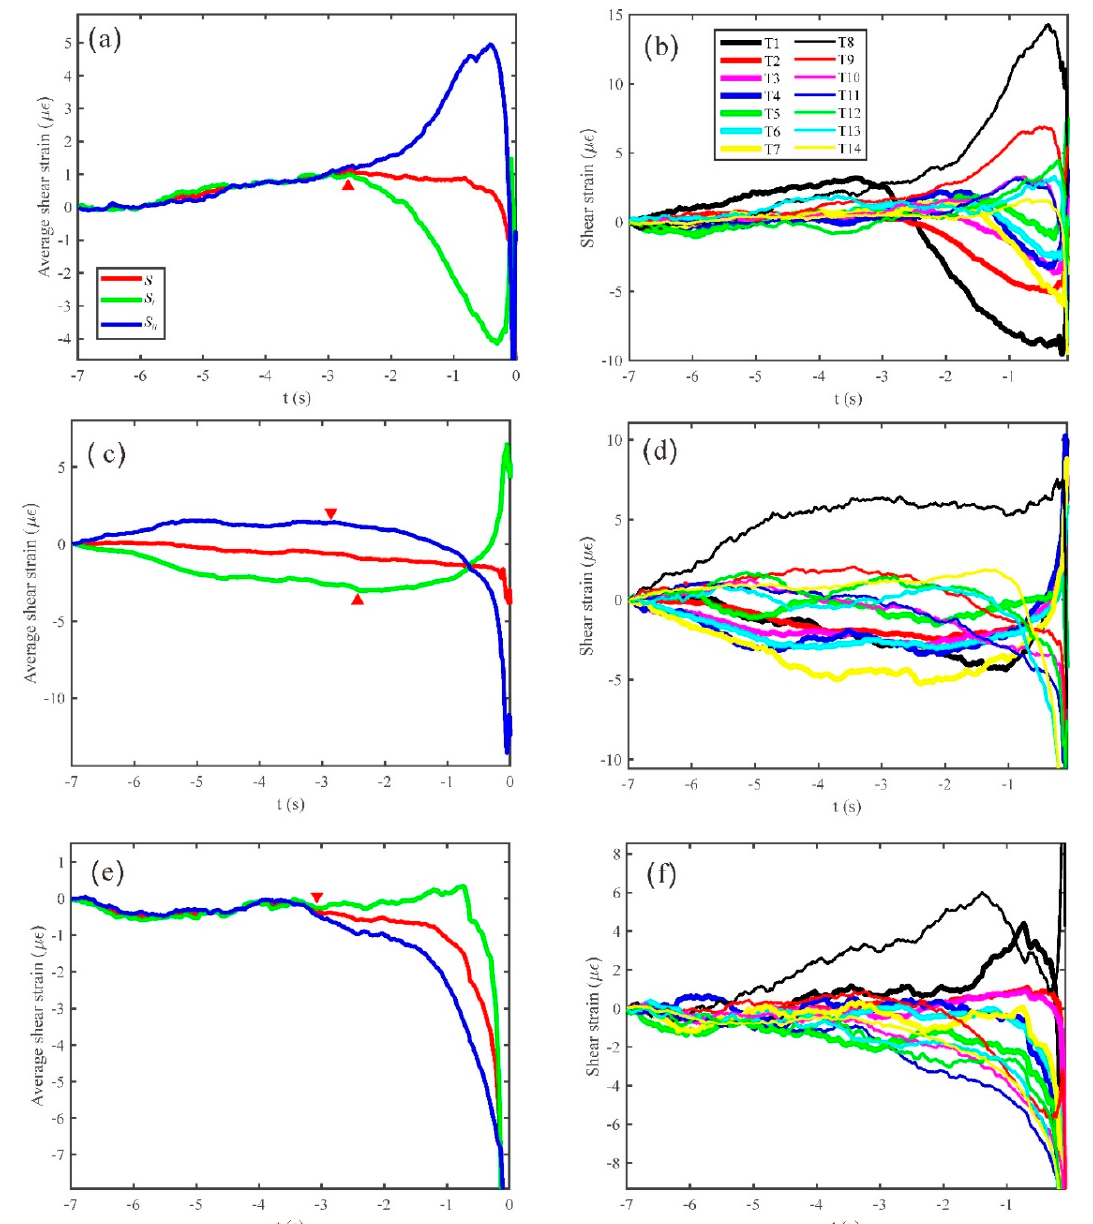
Figure 7. Variations of the shear strain with time. ( a ) and ( b ), ( c ) and ( d ), and ( e ) and ( f ) correspond to events E1, E2, and E3, respectively. ( a ), ( c ), and ( e ) are the average shear strains in the whole fault ( S ), the segment S I ( S I ), and the segment S II ( S II ), respectively. The red triangles indicate the turning points in the trend of the average shear strain. ( b ), ( d ), and ( f ) are the shear strains in each strain gage group. Groups T1–T7, which are mounted in the segment S I , are displayed with thick lines. Groups T8–T14, which are mounted in the segment S II , are displayed with thin lines. The common timing point of the data from the DIC method and strain gages is set zero for each stick-slip event. Accordingly, the time before and after the common timing point is negative and positive, respectively.